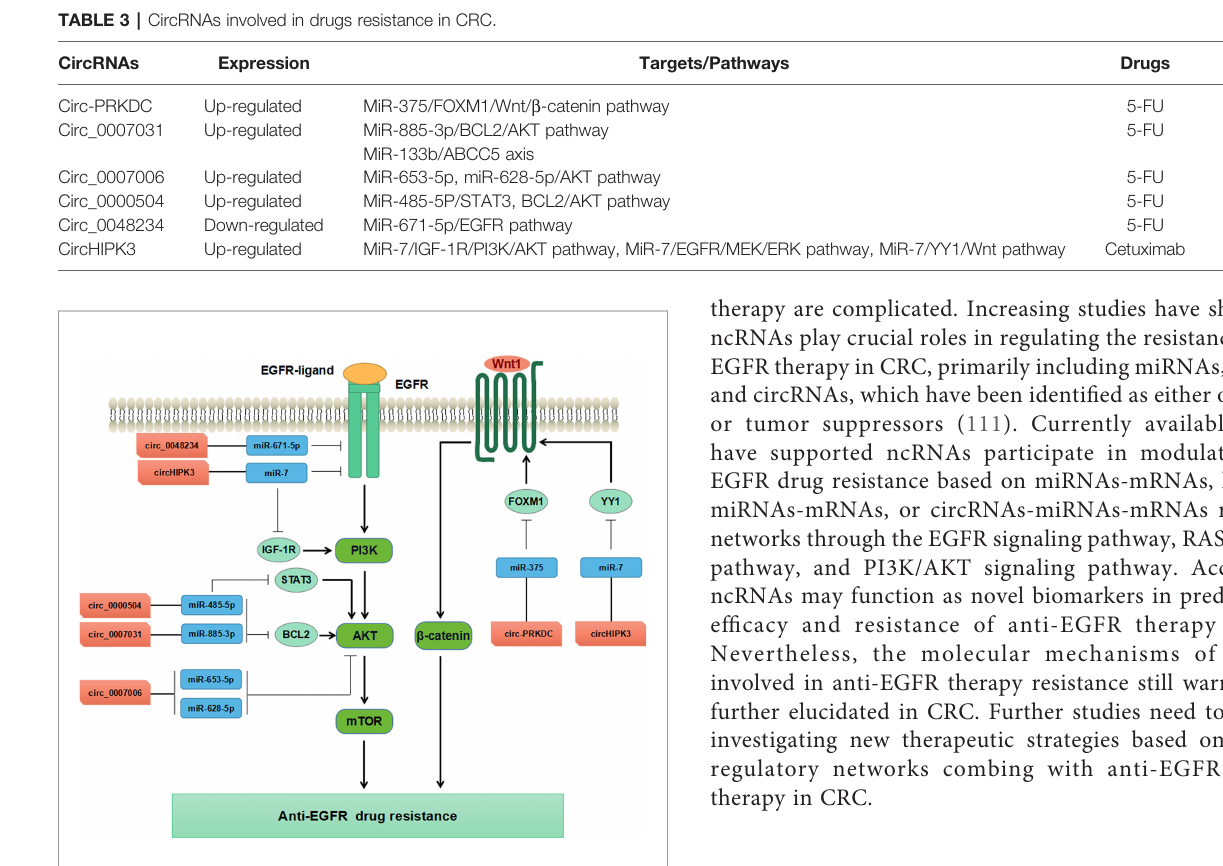
FIGURE 4 | Mechanisms of circRNAs regulating CRC drug resistance by modulating AKT, EGFR, and WNT pathways.